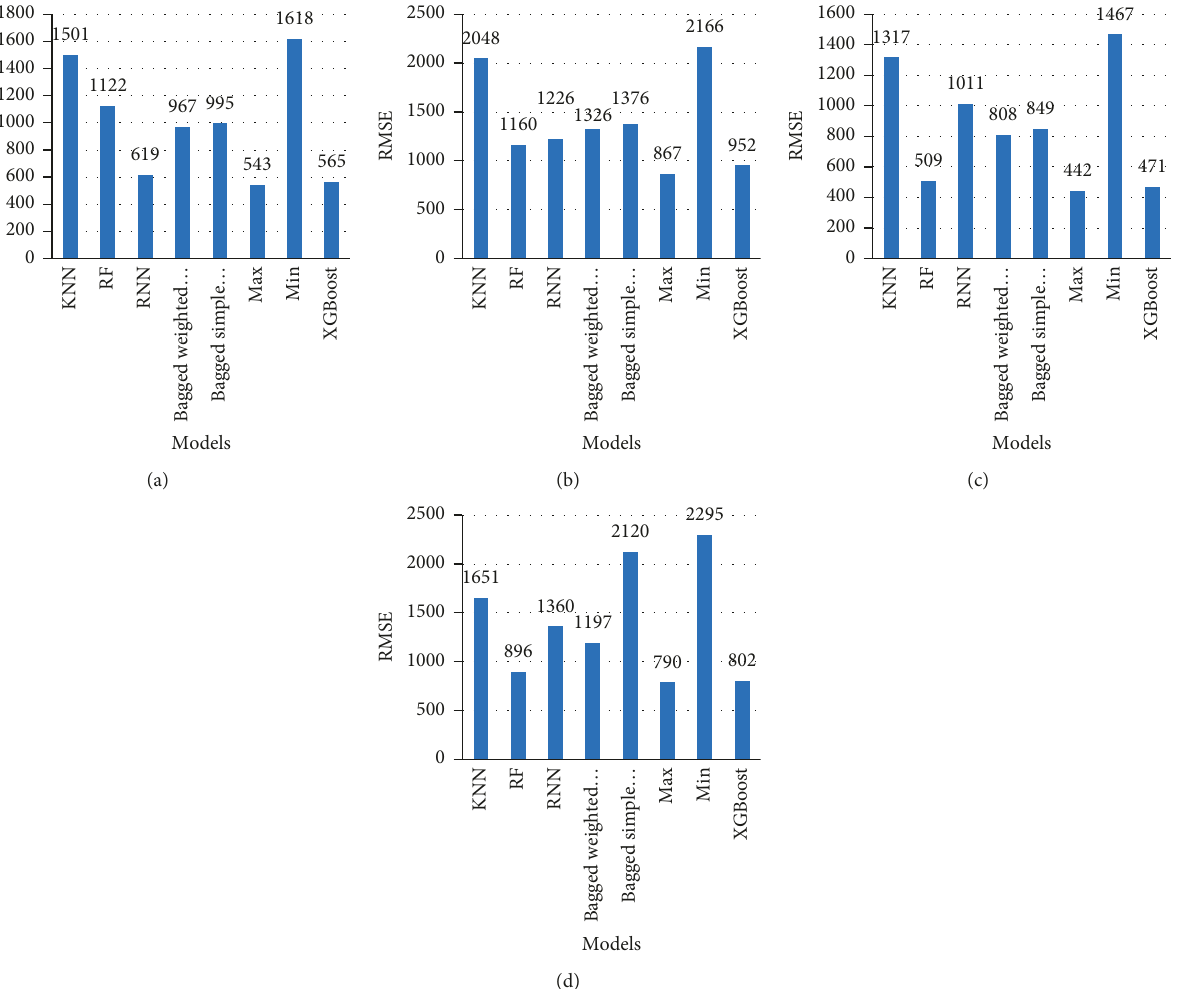
Figure 7: RMSE of the base, bagging, and stacking models for the fourth quartiles of the observed traffic flow. (a) Mid-term models of Tehran to Saveh. (b) Mid-term models of Saveh to Tehran. (c) Short-term models of Tehran to Saveh. (d) Short-term models of Saveh to